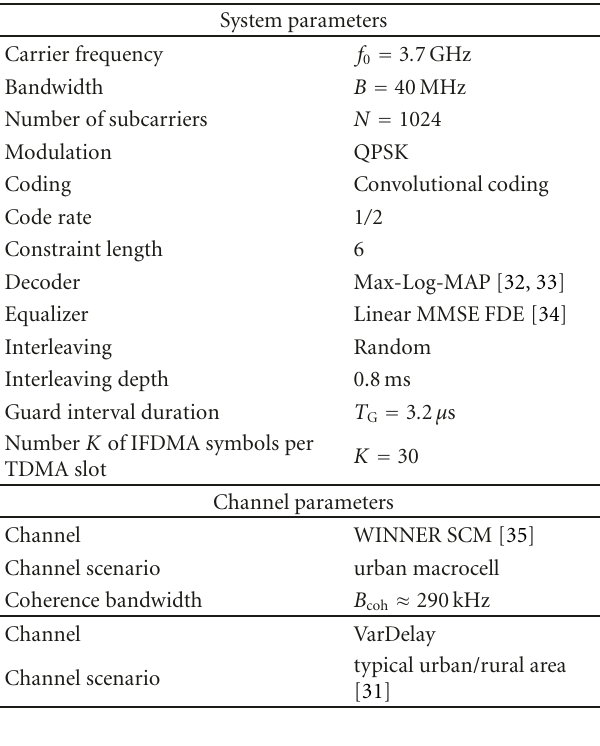
Table 2: System and channel parameters.